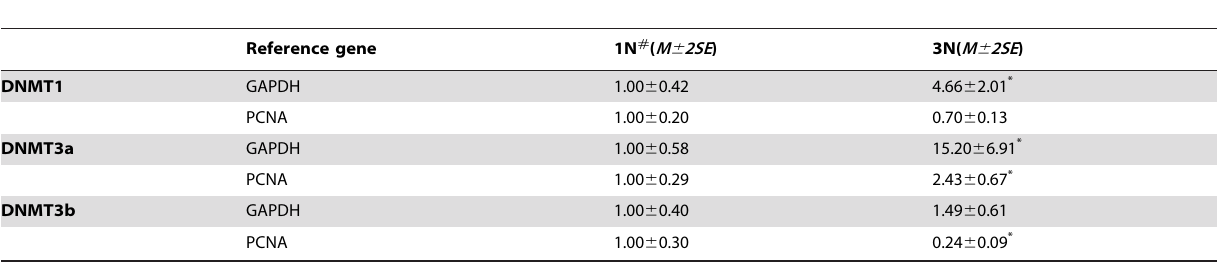
Table 4. DNMTs mRNA levels in first trimester (1N) and third trimester (3N) placentas.